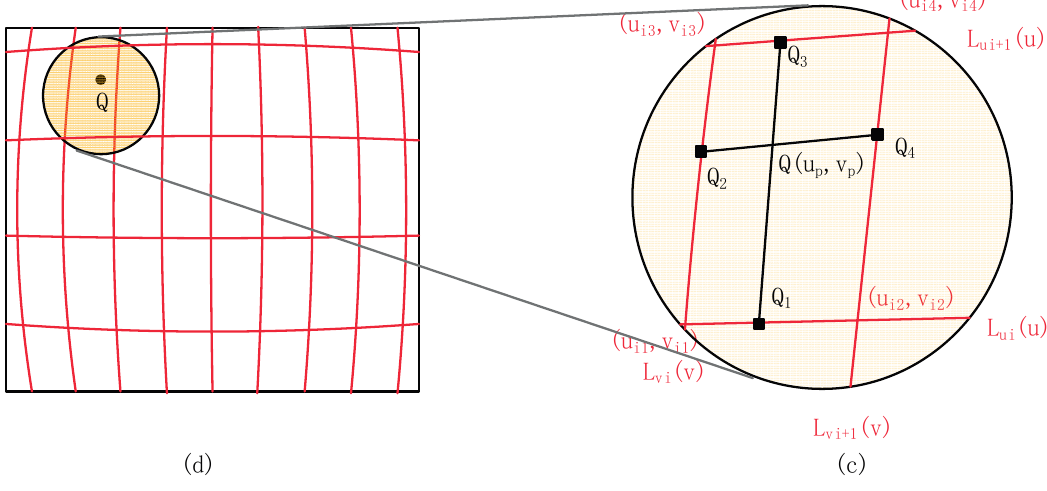
Figure 3. Precise interpolation method in point mapping correction method. ( a , b ) The dashed lines indicate the ideal grid created by VMPs in the image plane where, point Q’ is an ideal point of undistorted pattern on the image plane; ( c , d ) Red curves show the curves of the polynomial equations. The point Q is the corresponding point on the object plane mapped to the point